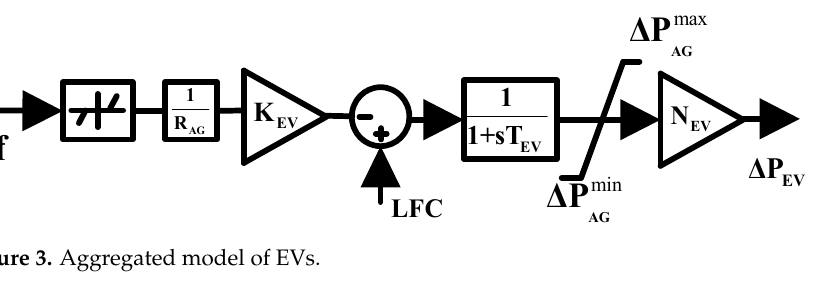
Figure 3. Aggregated model of EVs.